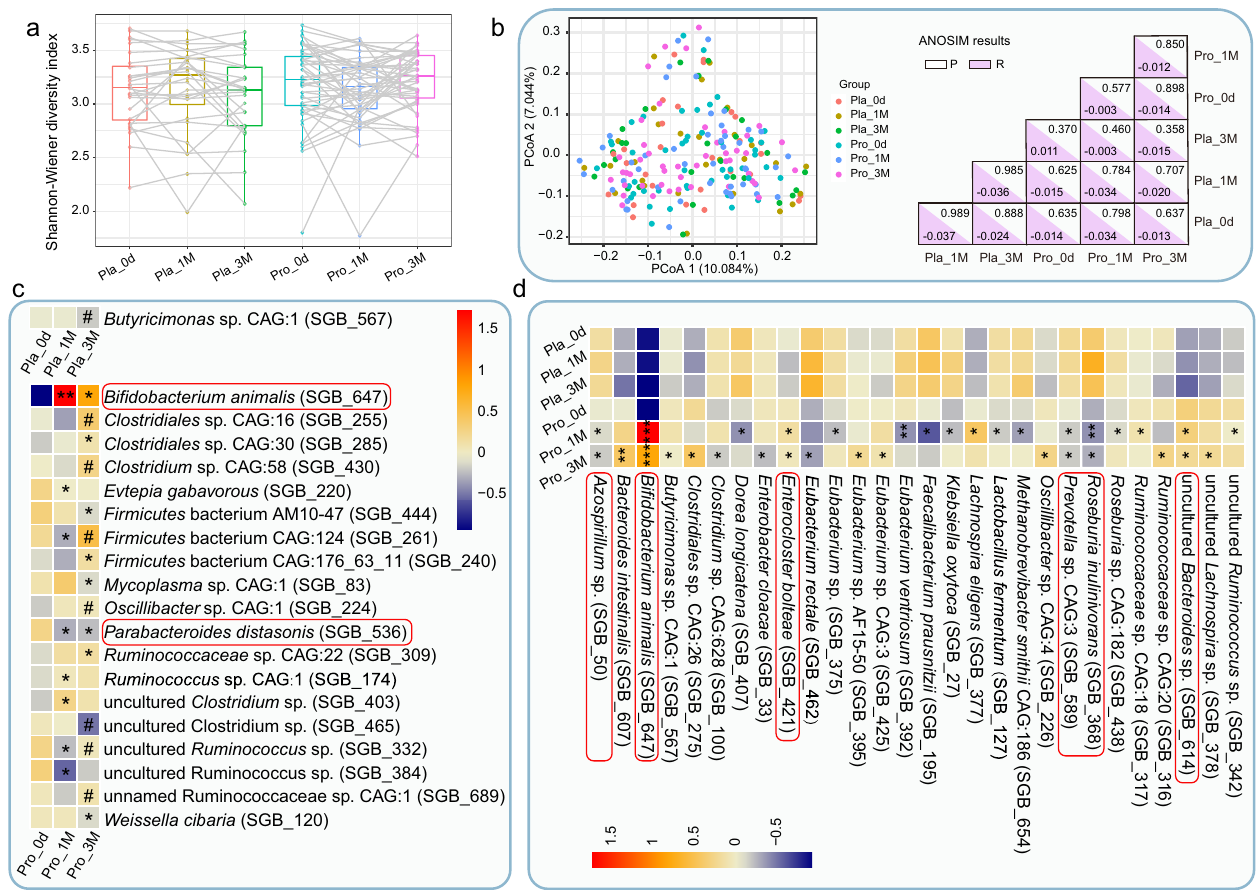
Fig. 2 Microbial diversity and differentially abundant species-level genome bins (SGBs) between groups. a Shannon diversity index of the fecal microbiome at 0d, 1 M, and 3 M in placebo and Probio-M8 groups, respectively. Statistical differences in the Shannon diversity index within groups were evaluated with paired t -tests. Each dot represents a data point of a participant, and data of the same participant at different time points are connected by straight lines. Boxplot elements: center line, median; box limits, upper and lower quartiles; whiskers, 1.5x interquartile range; points, outliers. b Left panel, principal coordinates analysis (PCoA) score plots of two groups at different time points. Samples of each subgroup are represented by a different color. Right panel, P value and R value of analysis of similarities (ANOSIM, 999 permutations). c Longitudinal comparisons of an abundance of SGBs of the same group between different time points. All the shown SGBs were not signi fi cantly different between groups at baseline but only increased/decreased signi fi cantly during the trial. Signi fi cant differences in speci fi c SGBs between 0d and other time points are represented by * P < 0.05 and ** P < 0.01; between 1 M and 3 M are represented by # P < 0.05. d Horizontal comparisons between an abundance of SGBs of Probio-M8 and placebo groups at the same time point. All the shown SGBs were not signi fi cantly different between groups at baseline but became signi fi cantly differential abundant during/after the intervention. Signi fi cant differences: * P < 0.05, ** P < 0.01, and *** P < 0.001. The red corner rectangles in ( c ) and ( d ) represents an abundance of SGBs on an arbitrary scale. “ Pro ” and “ Pla ” represent the Probio-M8 group and Placebo group, respectively. “ 0d ” , “ 1 M ” , and “ 3 M ” represent the baseline before intervention, 1 and 3 months after intervention, points (Fig. 2c), such as the abundance of Parabacteroides ( P .) distasonis (SGB_536), Mycoplasma sp. CAG:1 (SGB_83), and Evtepia gabavorous (SGB_220) decreased in probiotic group at 1 M and 3 M (Fig. 2c). Horizontal comparisons between SGBs of Probio-M8 and placebo groups at the same time point revealed 28 sig- ni fi cantly differential abundant SGBs (Fig. 2d). The levels of SGBs representing Klebsiella ( K .) oxytoca (SGB_27) and L. fermentum (SGB_127) were diminished. In contrast, the levels of SGBs representing Ruminococcaceae [ Ruminococcaceae sp. CAG:18 (SGB_317), Ruminococcaceae sp. CAG:20 (SGB_316), uncultured Ruminococcus sp. (SGB_342)], Lachnospira [ Lachnospira eligens (SGB_377), uncultured Lachnospira sp. (SGB_378)], and Butyrici- monas [ Butyricimonas sp. CAG:1(SGB_567)] increased in Probio-M8 group (Fig. 2d). Our results suggested that co-supplementation of Probio-M8 modulated the patients ’ gut microbiota desirably by suppressing some potentially pathogenic taxa while increasing the bene fi cial ones. uncultured Ruminococcus sp (SGB_384). Of particular interest